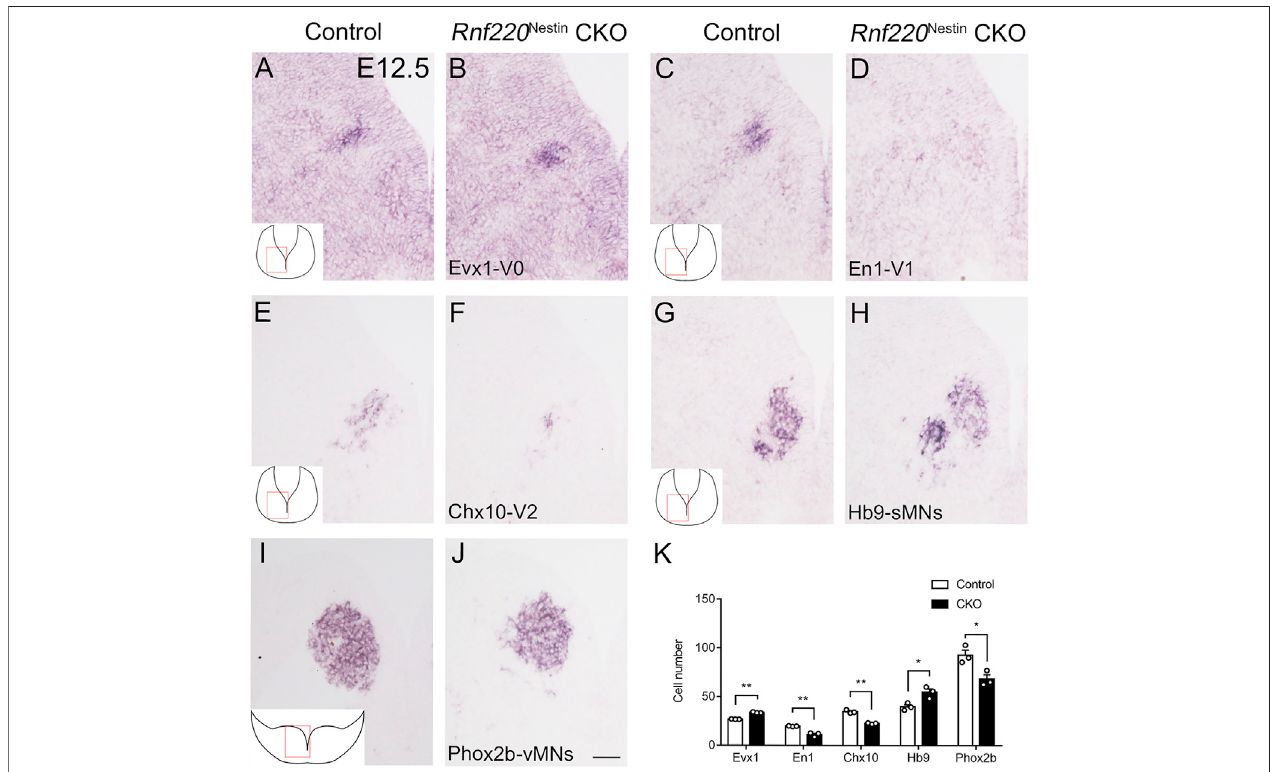
FIGURE 4 | Changes in the Domains of Post-mitotic Neurons in the Ventral Hindbrain Neural Tube of Rnf220 Nestin CKO Embryos at E12.5. (A,B) More Evx1 + V0 neuronsareobservedin Rnf220 Nestin CKOembryos (B) thanincontrols (A) . (C,D) The En1 + V1neuronsarehardlydetectedin Rnf220 Nestin CKOembryos (D) compared with the V1 neuronal domain in controls (C) . (E,F) The number of Chx10 + V2 neurons is reduced in Rnf220 Nestin CKO embryos (F) compared with controls (E) . (G,H) Hb9 + somaticmotorneurons(sMNs) areincreasedin Rnf220 Nestin CKOembryos (H) compared withcontrols (G) . (I,J) Phox2b + visceralmotorneurons(vMNs)are reduced in Rnf220 Nestin CKO embryos (J) compared with controls (I) . Scale bar, 50 μ m (J) ; also applies to (A – I) . Insets (A,C,E,G,I) are schematic diagrams of the hindbrain level and position shown in (A – J) . (K) Quanti fi cation of different groups of post-mitotic neurons in the ventral hindbrain neural tube of control and Rnf220 Nestin CKO embryos. Data are expressed by mean ± SEM. Student ’ s t -test ( n =3 for each). *, p < 0.05; **, p < 0.01.